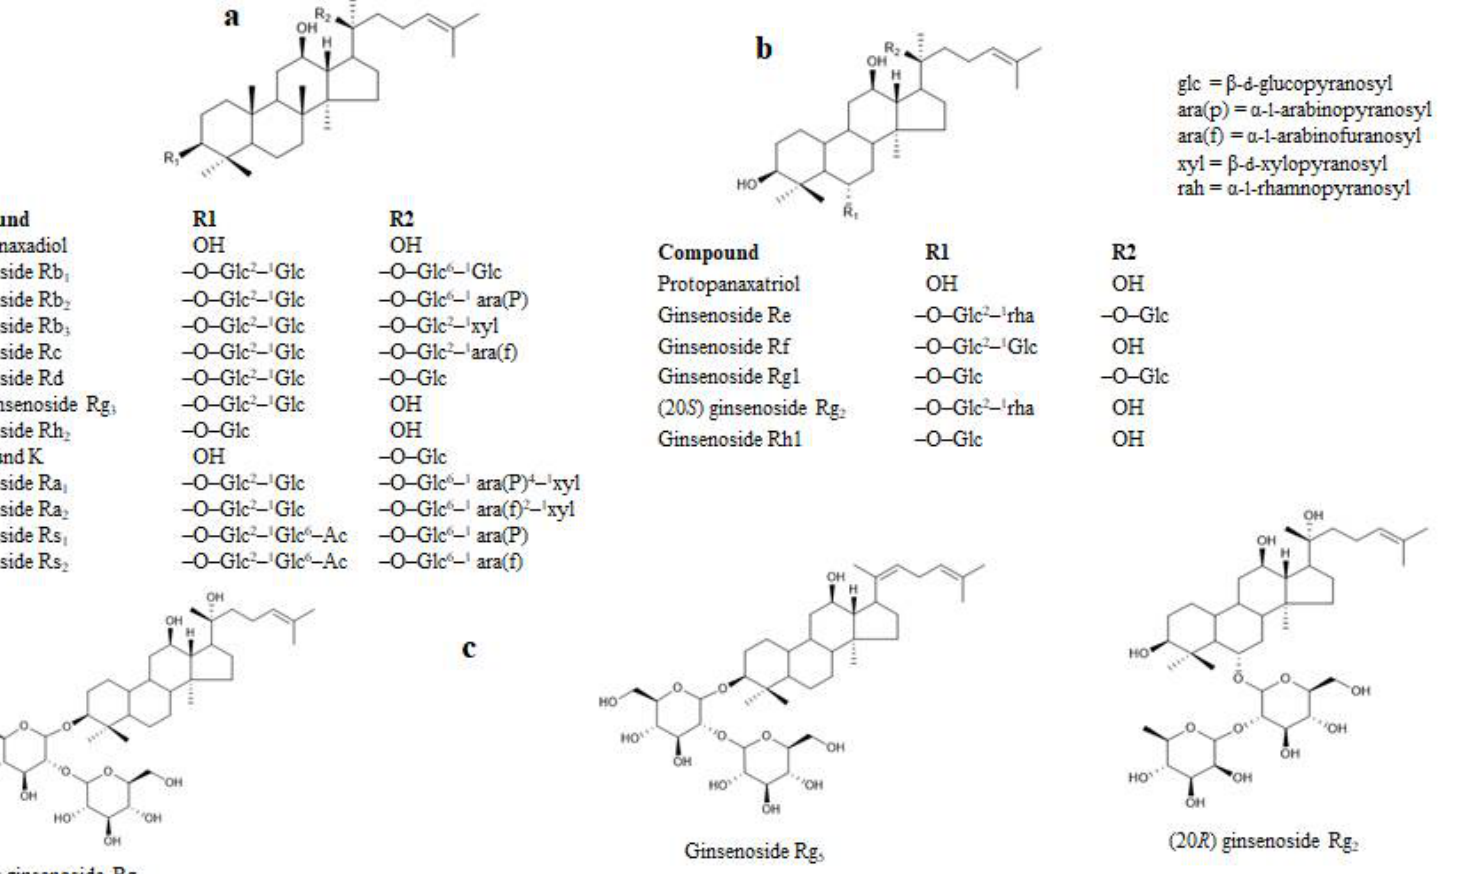
Figure 1. Structure of selected ginsenosides. ( a ) PPDs. ( b ) PPTs. ( c ) Derivatives of PPDs and PPTs. Glc, β- D -glucopyranosyl; ara(P), α- L -arabinopyranosyl; ara(f), α- L -arabinofuranosyl; Xyl, β-dxylopyranosyl; rah, α- L -rhamnopyranosyl.